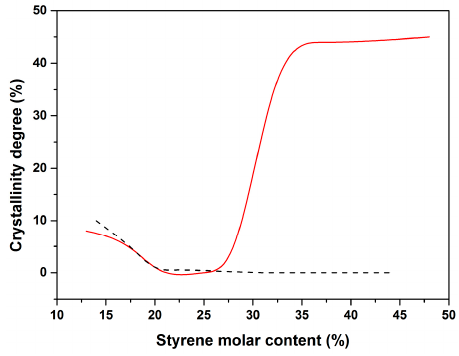
Figure 4. Crystallinity degree of ES copolymers vs. styrene molar content: copolymers obtained with ansa -zirconocene catalyst ( solid line ); copolymer obtained with half-titanocene catalyst ( dash line ).